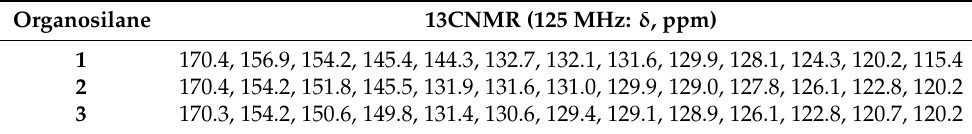
Table 4. 13 C NMR spectral data for organosilanes 1 – 3 .